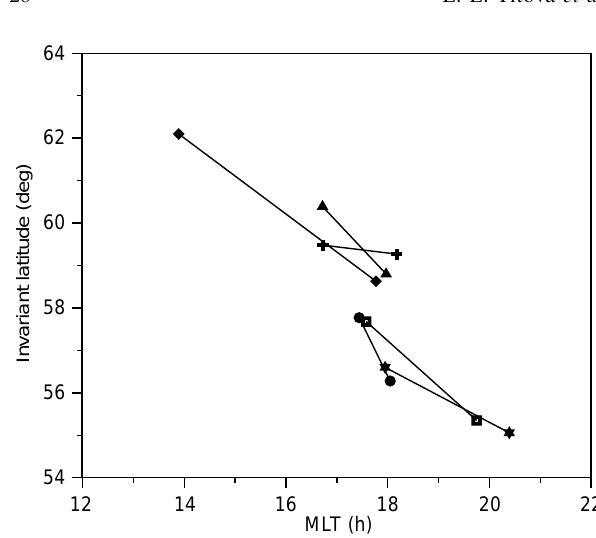
Fig. 4. Dependence of the cli(cid:128) latitude on MLT for almost simultaneous observations by two longitudinally separated satellites for the events listed in